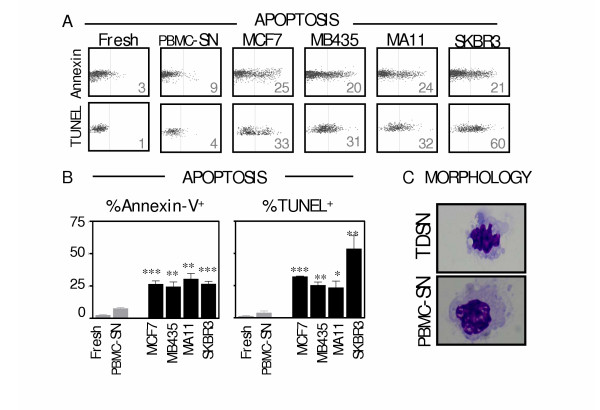
Apoptosis in blood dendritic cells (DCs) is induced by breast tumor-derived supernatants. (a)Apoptosis in blood DCs was determined by Annexin-V binding and TUNEL assays following culture (24 h) in the presence of 50% (v/v) peripheral blood mononuclear cell (PBMC)-derived supernatant (PBMC-SN) or tumor-derived supernatants (TDSN; MCF7, MB435, MA11 and SKBR3). Representative dot plots (SSC on y-axis versus apoptosis on x-axis) are shown with numbers indicating the percentage of apoptotic cells. (b)Summary of apoptosis data. The proportions of Annexin-V+ and TUNEL+ blood DCs represent the average ± standard error of the mean of five independent experiments for which statistically significant differences compared to PBMC-SN are shown: *, p < 0.05; **, p < 0.01; ***, p < 0.001. (c)For morphological analyses (original magnification times 1,000), 50 cells were assessed in three separate fields. In contrast to PBMC-SN, cultures incubated with TDSN (MA11) frequently demonstrated features of apoptotic death in blood DCs (reduction in cell volume and nuclear size, cytoplasmic blebbing, cell membrane convolutions and formation of apoptotic bodies). Three independent experiments with similar findings were performed.